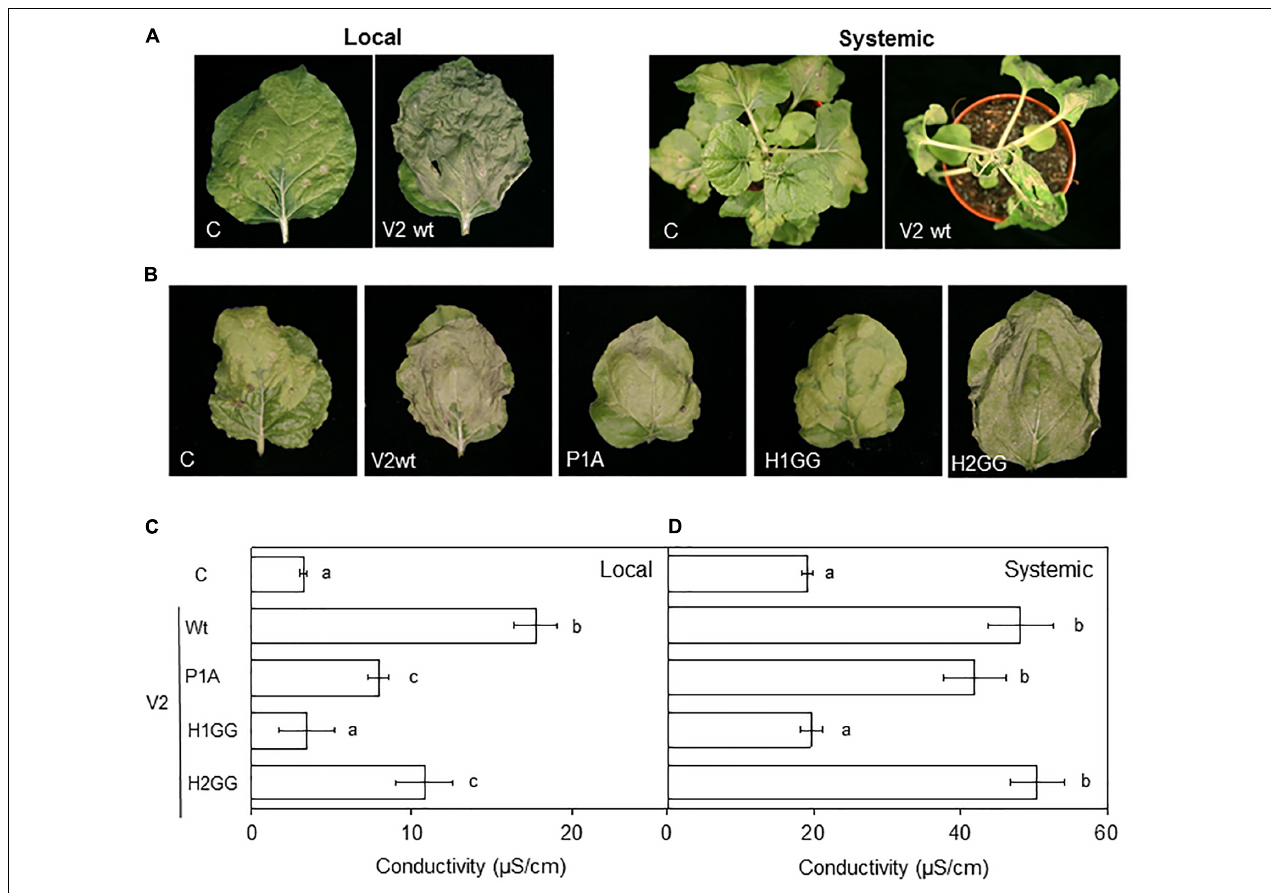
FIGURE 4 | Expression of BCTV V2 mutants from PVX. Wild-type or mutated versions of V2 were expressed from a PVX vector and tested individually in N. benthamiana leaves. (A) Infiltrated tissue (local) at 6 dpi or apical tissue at 10 dpi (systemic) with the empty PVX vector (C) or with a recombinant PVX virus expressing the wild-type V2 protein (V2wt). (B) Infiltrated tissue (local) at 6 dpi with the empty PVX vector (C) or with a recombinant PVX virus expressing the wild-type (V2wt) or the mutated versions (P1A, H1GG, H2GG) of V2. (C,D) Measurement of the conductivity from leaf discs extracted from local (C) or systemically infected (D) tissues. Seven to eight plants were infected with each PVX-derived construct and conductivity ( µ S/cm) was measured in two pools of four leaf discs per plant. Bars represent mean values ± standard error (SE) for seven to eight plants (four discs per leaf were pooled and two leaves per plant were used) per recombinant PVX construct. Mean values marked with different letter (a, b, or c) indicate results significantly different from each other, as established by One Way ANOVA (Dunnett’s Multiple Comparison Test; P < 0.05). Similar results were obtained in two independent